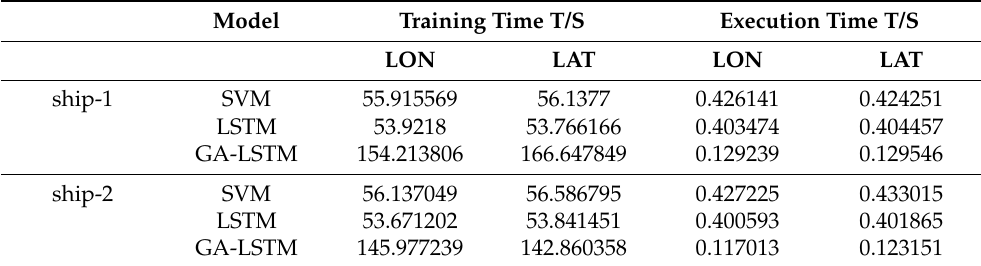
Table 3. Comparison of real-time analysis of 3 models.